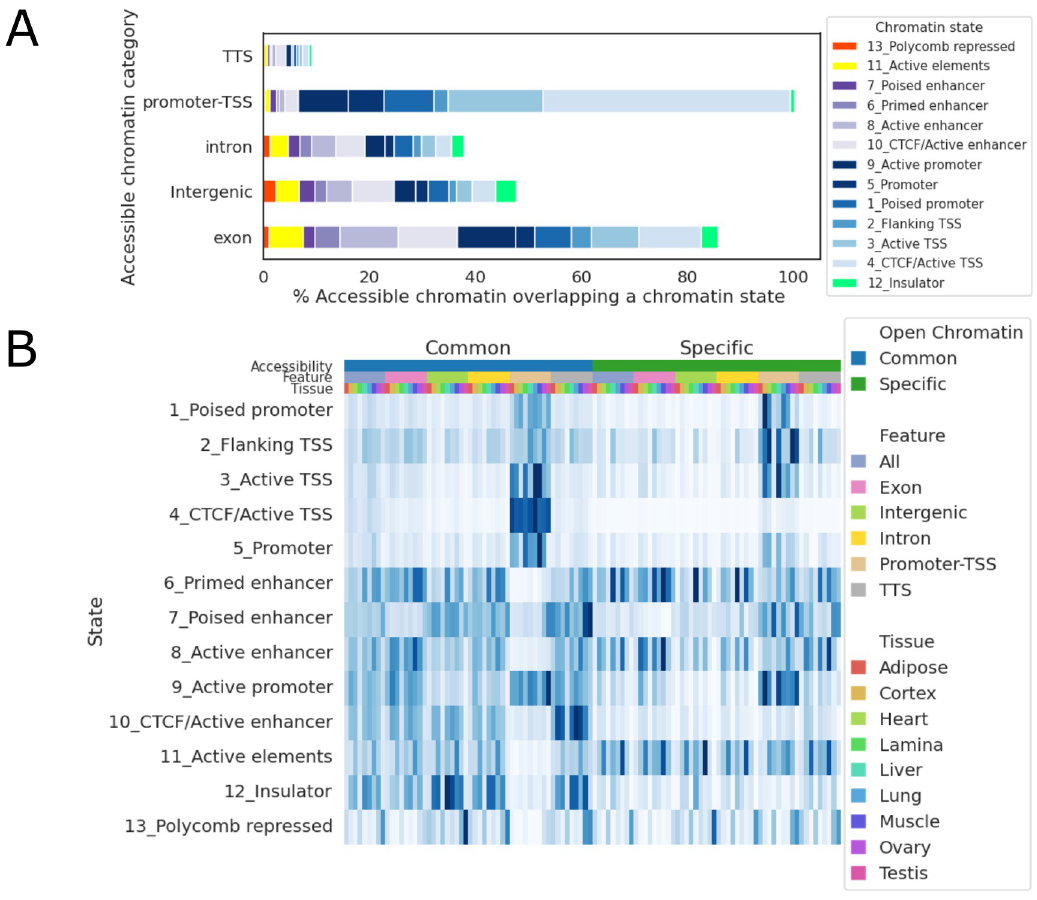
Fig 8. Chromatin accessibility across states. (A) Percentage of open chromatin peaks that overlap each chromatin state. (B) Heatmap of enrichment for each state around open chromatin peaks. The top three color bars denote shared or tissue-specific open chromatin, open chromatin annotation, and tissues, respectively. Enrichment scores were normalized in each